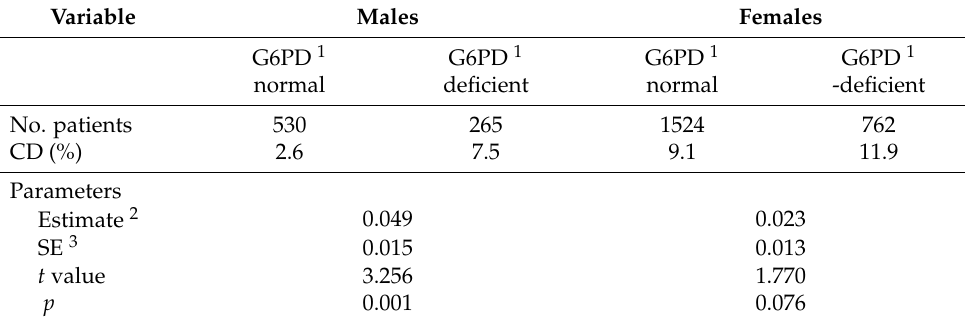
Table 3. Propensity score matching 2:1 in males and females. Variable